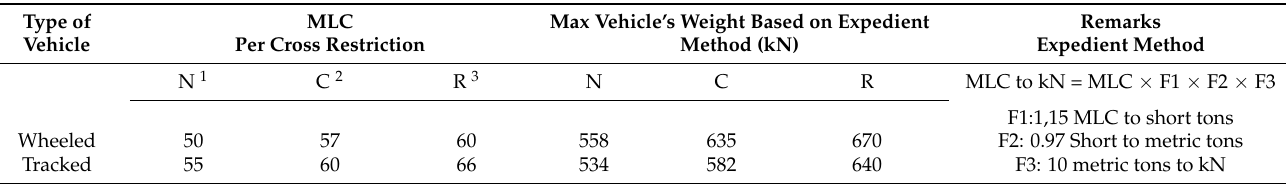
Table 7. TS-30.48 m Bailey Bridge Military Loading Class (MLC).